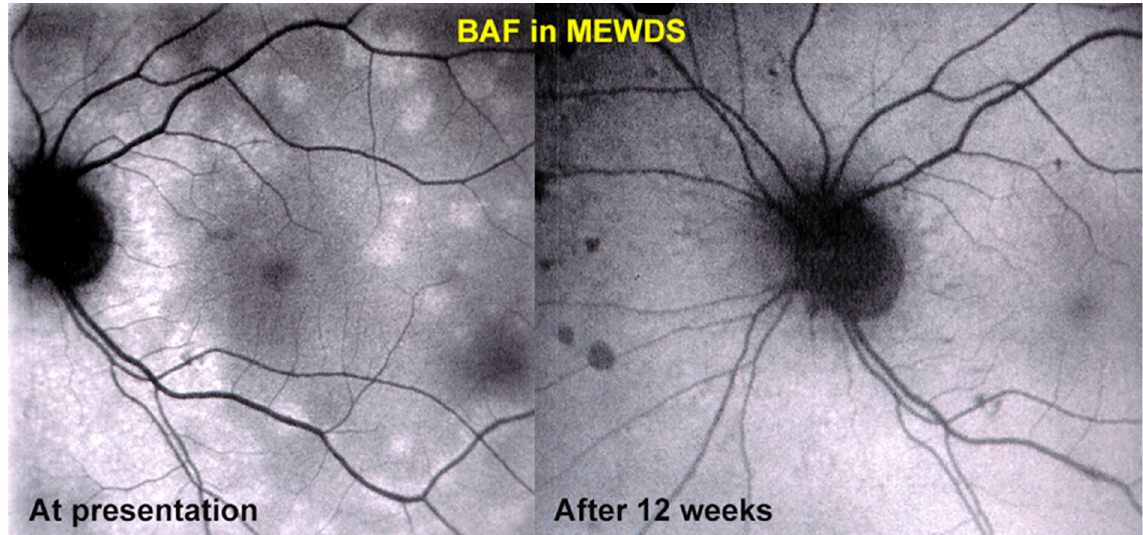
Figure 2. BAF in choriocapillaritis. BAF is of comparable value to ICGA to follow choriocapillaritis entities such as MEWDS or MFC. This patient was diagnosed and followed as MEWDS thanks to BAF. At presentation, numerous areas of hyperautofluorescence were observed ( left ), but disap- peared 12 weeks later without treatment ( right ). However, after resolution of hyperautofluores- cence areas, scars (dark dots nasal to disc on right) were noted as compatible with MFC. Indeed, the patient developed a recurrence 2 years later and the diagnosis was reverted to